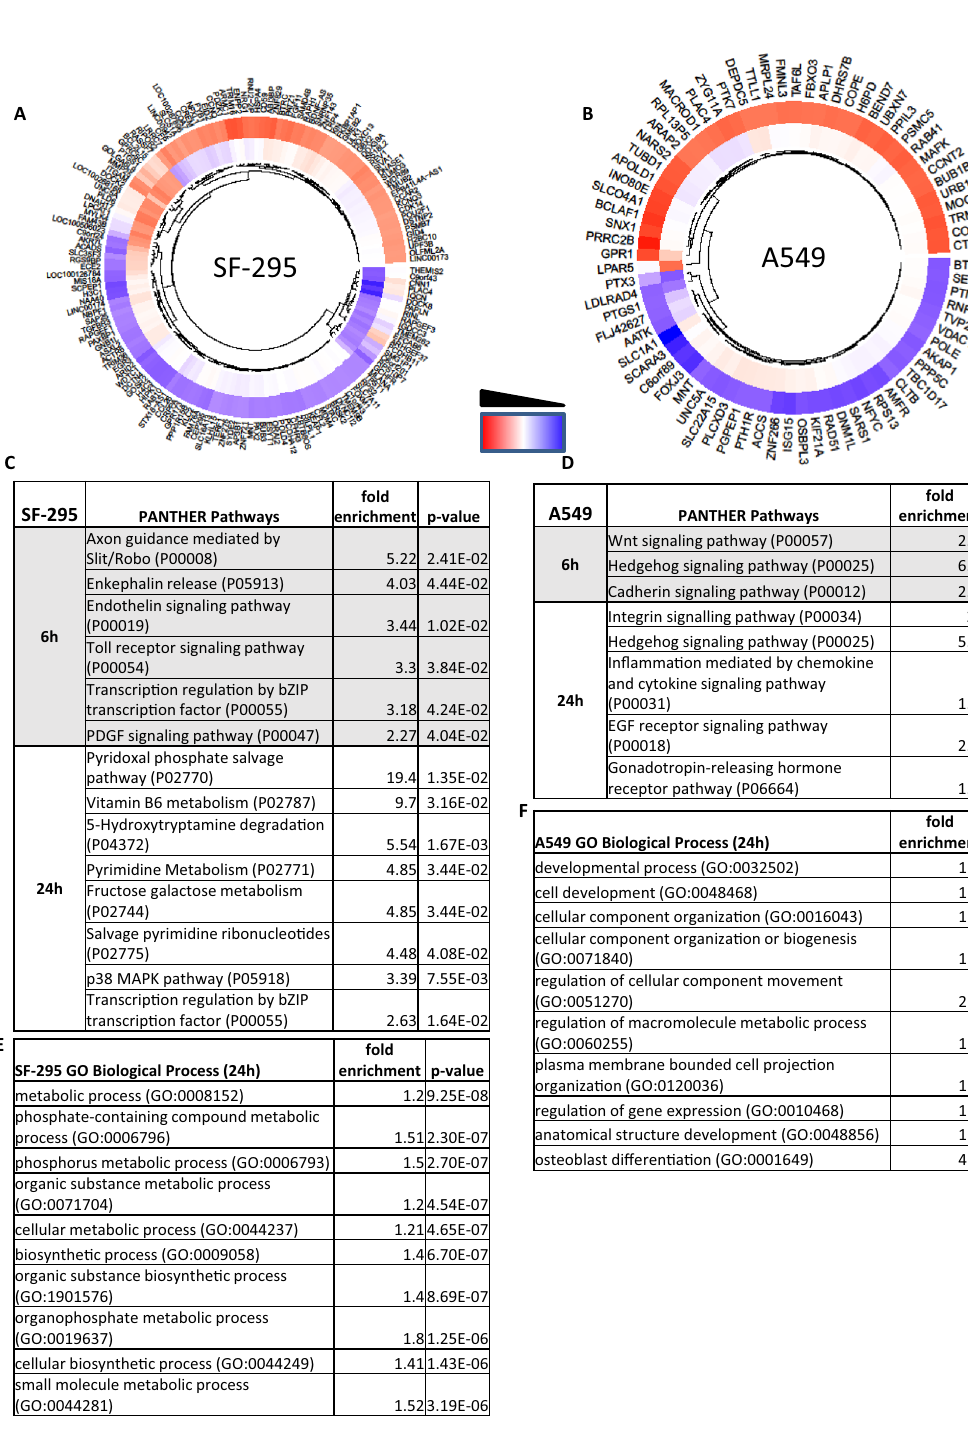
Figure 4. RNAseq of SF-295 and A549 cells treated with 50 nM TTI-3066 for 6 h or 24 h. Data is expressed as log 10 (treated–untreated). All heatmaps were generated with |log 10 (treated–untreated)|> 2, with 6 h data represented as the outside of the ring and 24 h data as the inside of the ring. Heatmaps of significantly altered genes in SF-295 ( A ) and A549 ( B ) are presented. Gene enrichment analysis for PANTHER pathways are included for SF-295 ( C ) and A549 ( D ) at 6 h and 24 h. Reactome and GO pathway analysis are included in supplemental tables. Principal components plots for 6 h (Supplementary Fig. 3A) and 24 h (Supplementary Fig. 3C) are included. At 6 h (Supplementary Fig. 3B) and 24 h (Supplementary Fig. 3D), some genes were differentially regulated similarly between SF-295 and A549. GO biological process top hits at 24 h for SF-295 ( E ) and A549 ( F ) are shown, with further GO and Reactome pathway analysis included in Supplementary Table